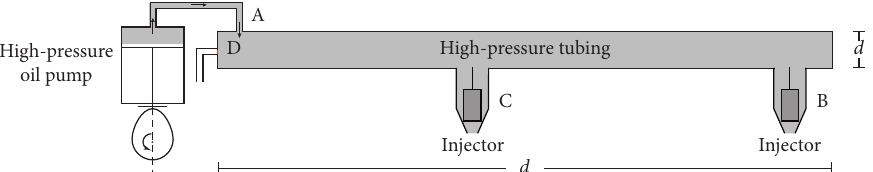
Figure 1: Schematic of the working mechanism of high-pressure fuel line.